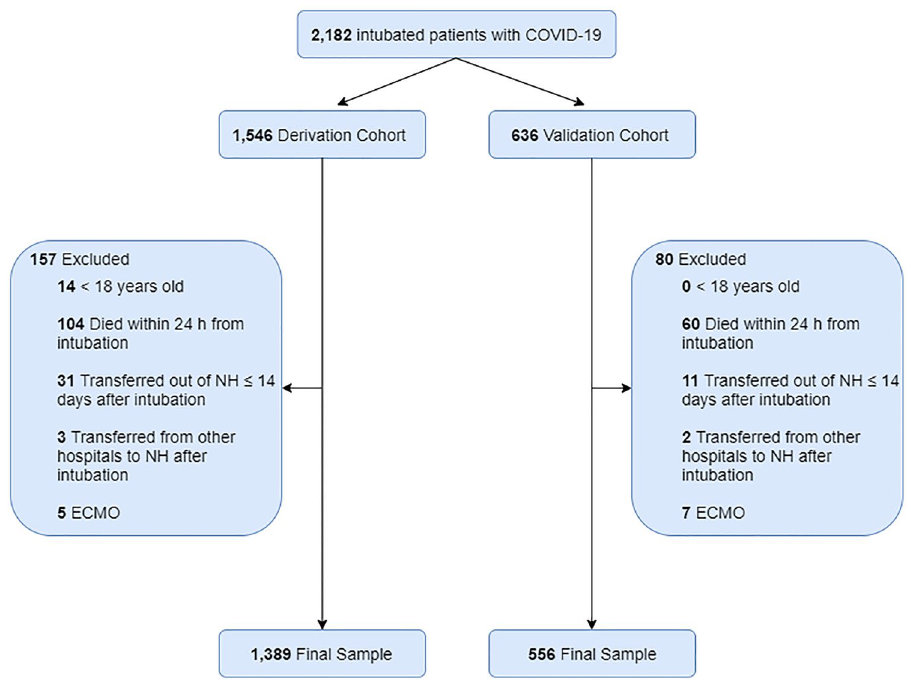
Figure 1. Flow diagram of patients. NH , Northwell Health; ECMO , extracorporeal membrane